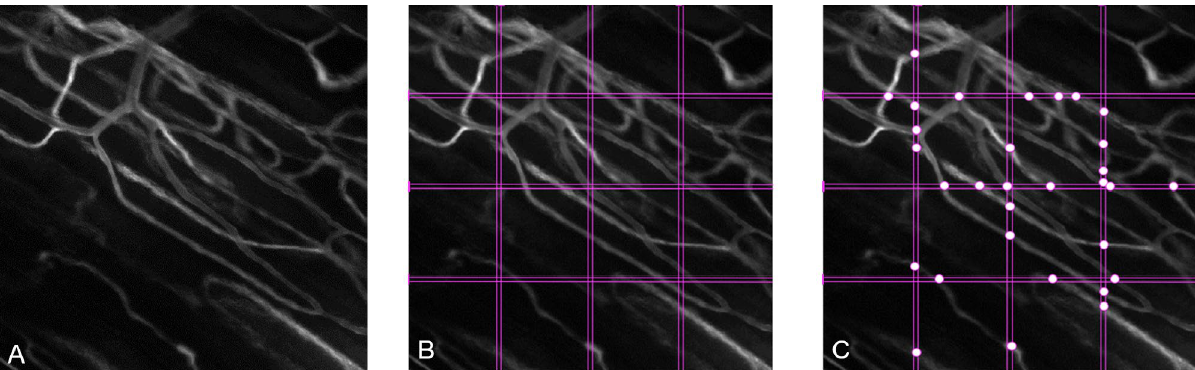
Figure 4. Image of the Sum of Absolute Differences. (A) Original SAD image (FOV: 400 × 400 µm). (B) Three sets of two equidistant horizontal and vertical lines acting as a visual reference. (C) Intersections of perfused vessels are manually identified between the lines and cross-referenced with associated intravital microscopic video recording 45,46